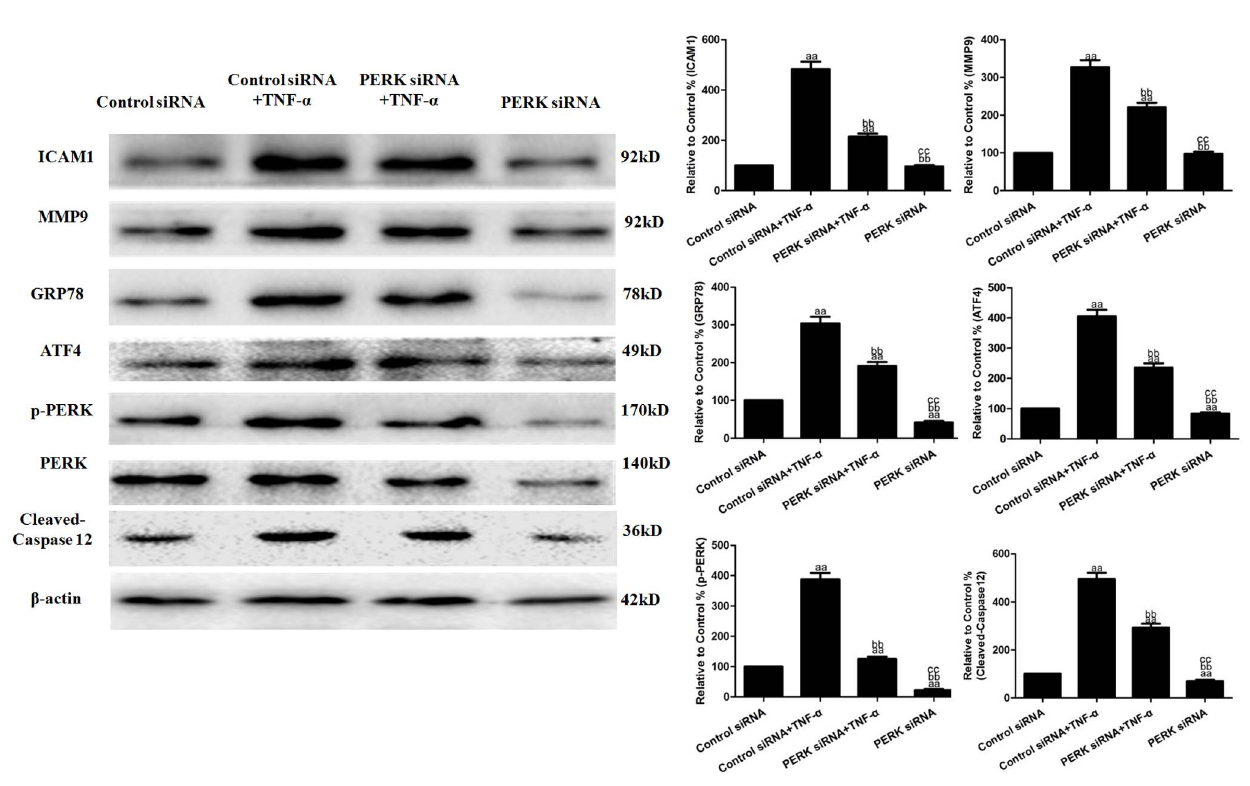
Figure 7. Effects of PERK siRNA on the TNF- a -induced inflammatory protein and ERS-related molecules in HUVECs. Representative Western blot results showingICAM1, MMP9, GRP78, ATF4, cleaved-caspase12, p-PERK and PERK protein expression. The results are expressed as the means ¡ SD, n 5 6. aa P , 0.01, compared with the control siRNA group; bb P , 0.01, compared with the control siRNA + TNF- a group; cc P , 0.01, compared with the PERK siRNA + TNF- a group. EP, ethyl pyruvate.